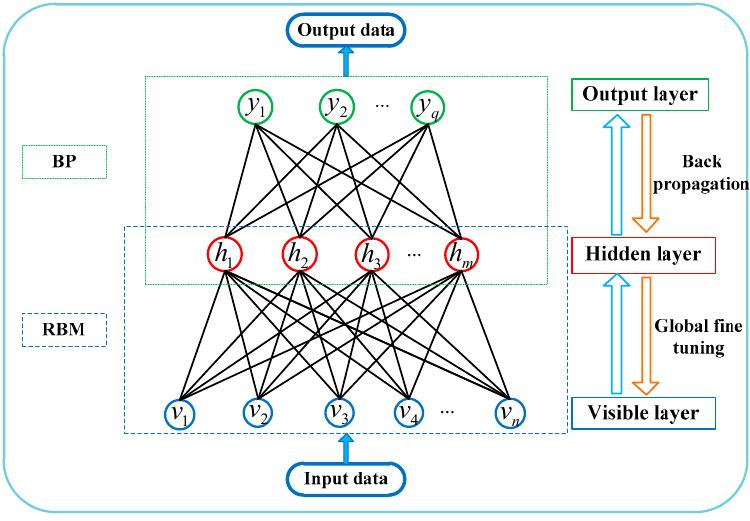
Figure 3. RBM-BPNN network